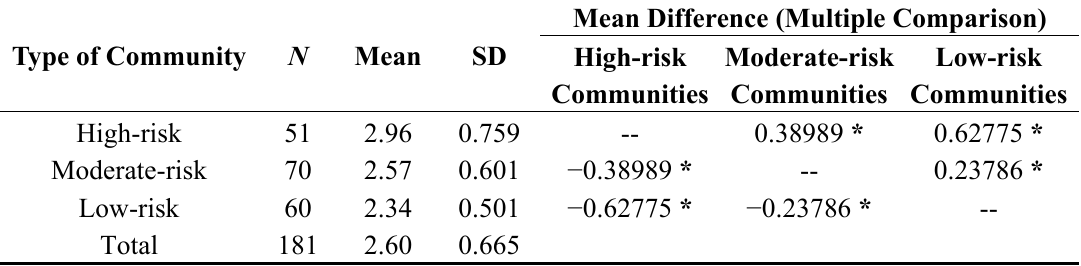
Table 7. Differences in means of risk perception scores given by respondents in three types of